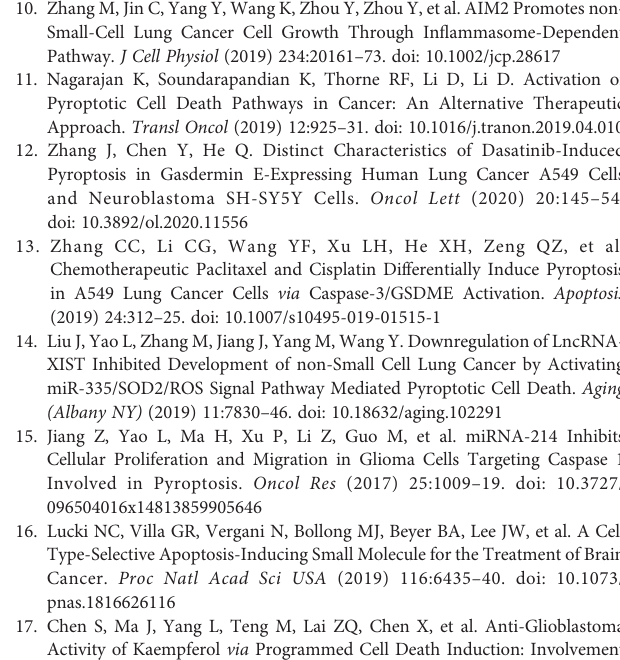
Supplementary Figure 2 | Kaplan-Meier curves of 13 identi fi ed pyroptosis- related lncRNAs in TCGA. (A – M) CRNDE, DICER1.AS1, LBX2.AS1, LINC00339, LINC00665, LINC00900, MIR155HG, NEAT1, NNT.AS1, PAXIP1.AS2, SNHG18, TTC28.AS1, WAC.AS1 Supplementary Figure 3 | (A) Nomograph plot of predicted 1-,3-and 5-year overallsurvivalprobabilitybasedonprognosissignature. (B – D) Calibrationplotsofthe nomogramforpredictingtheprobabilityofOSat1,3,and5yearsintheCGGA. (E – G) Time-dependent receiver operating characteristic (ROC) curves for the nomogram, risk score, age and grade in the CGGA dataset (for predicting 1, 3, and 5-year OS). Supplementary Figure 4 | Relative expression of pyroptosis-related lncRNAs in tumor samples. (A) LINC00900; (B) MIR155HG; (C) CRNDE; (D) TTC28.AS1; (E)